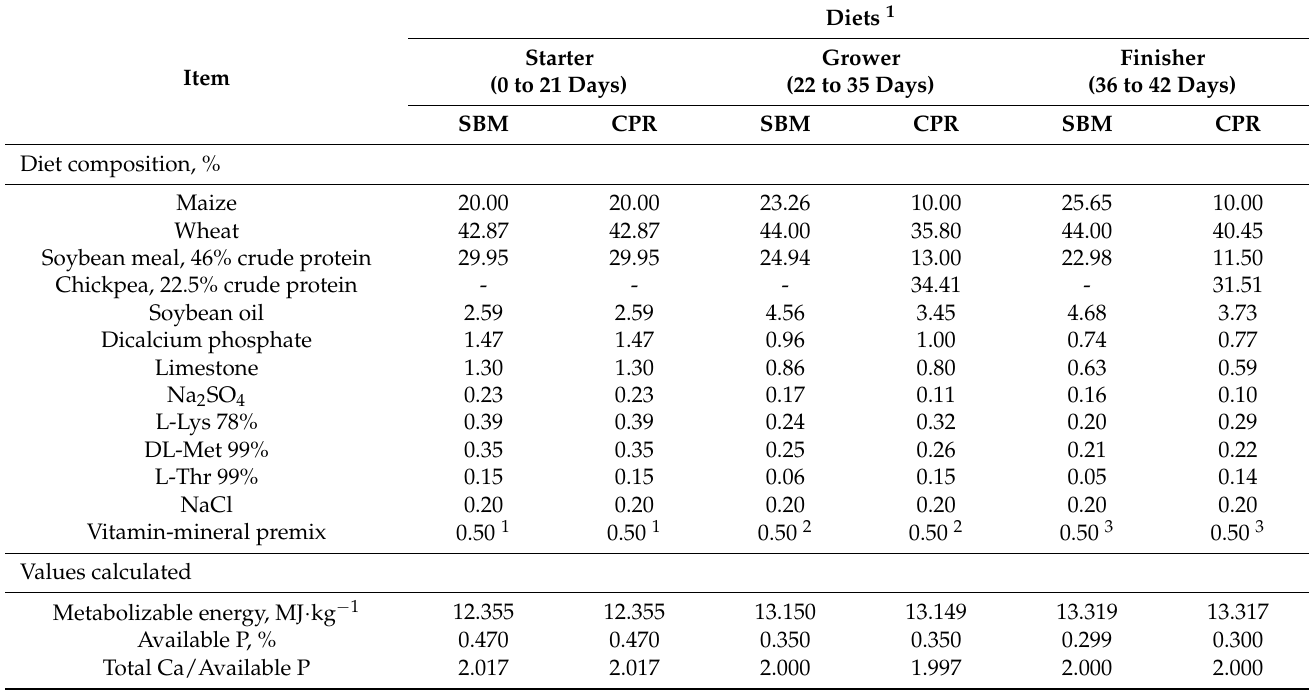
Table 1. Components and chemical composition of starter, grower, and finisher diets for experimental male broilers